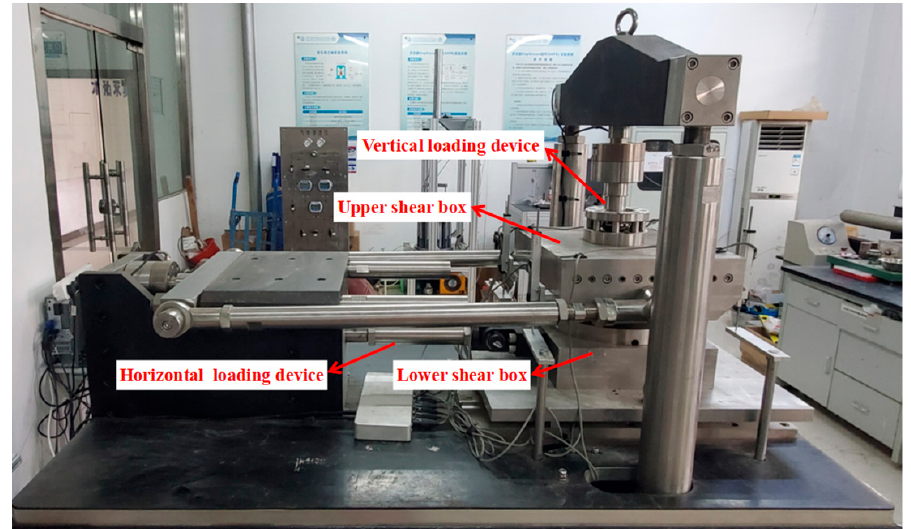
Figure 1. Cyclic shear apparatus.